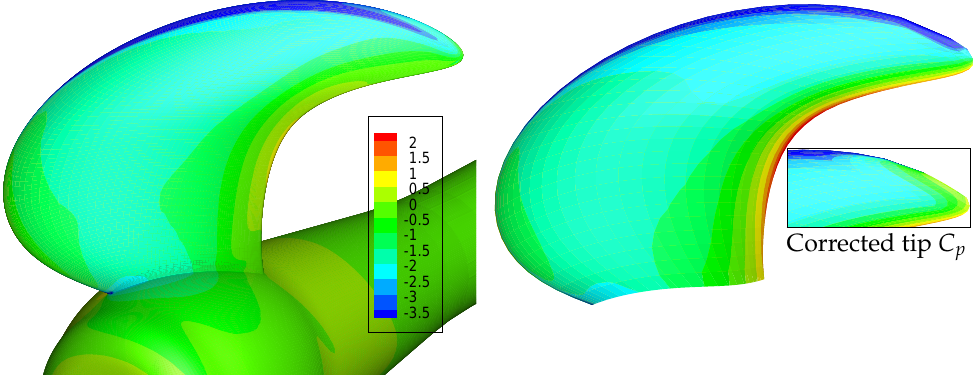
Figure 9. Pressure coefficient, C p , on the suction side for J = 0.64, RANS ( left ) BEM ( right ). The insert figure shows the BEM pressure distribution after the tip pressure